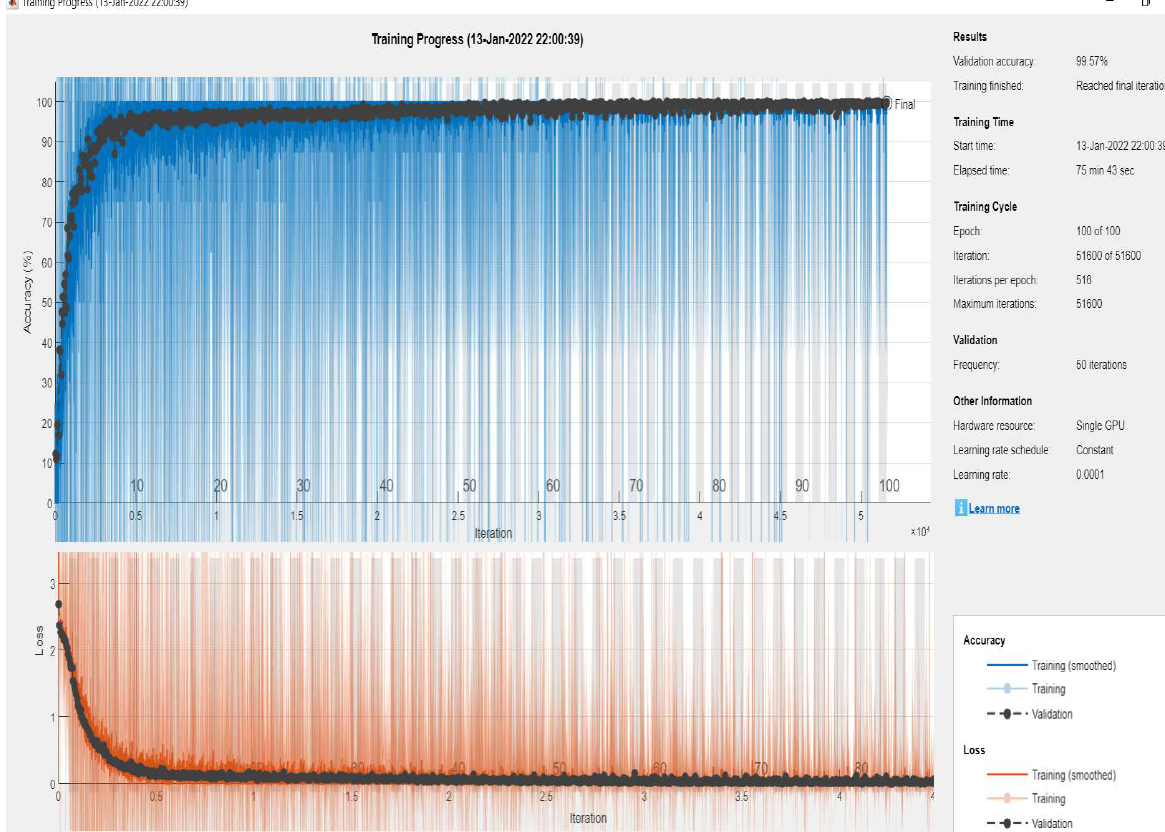
Figure 17. Accuracy and loss rate of FE for noisy LFM by CNN.